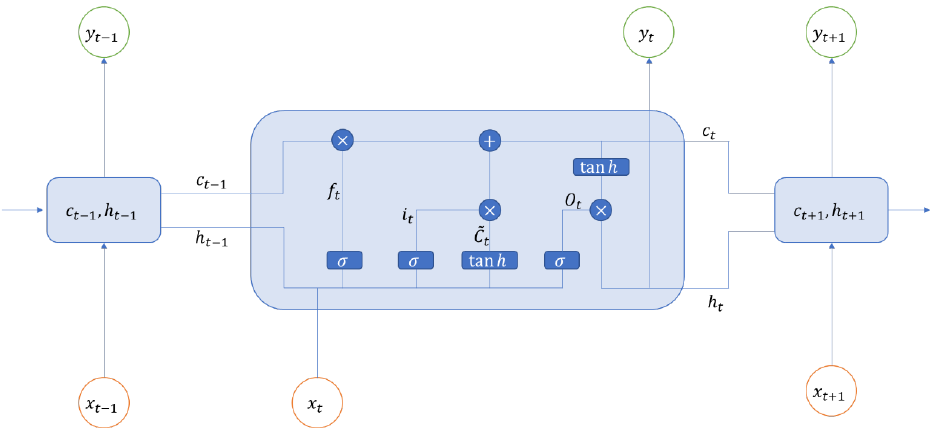
Figure 3. The LSTM